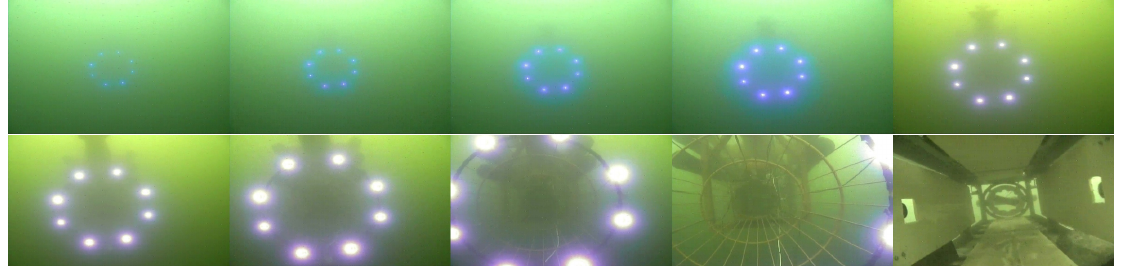
Figure 12. Trajectories of four recycling runs.